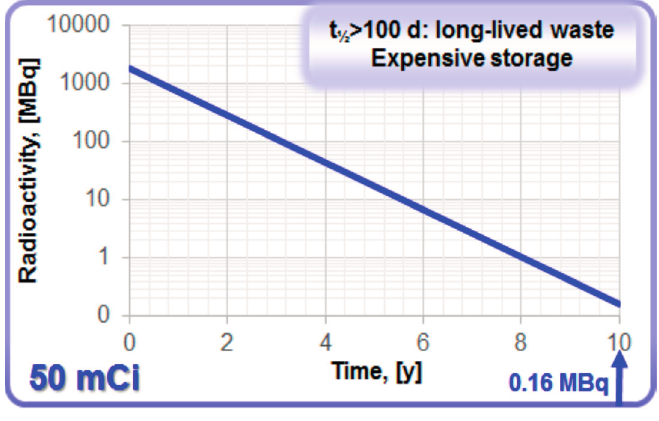
Figure 5. Decay of 68 Ge in a generator with loaded radioactivity of 50